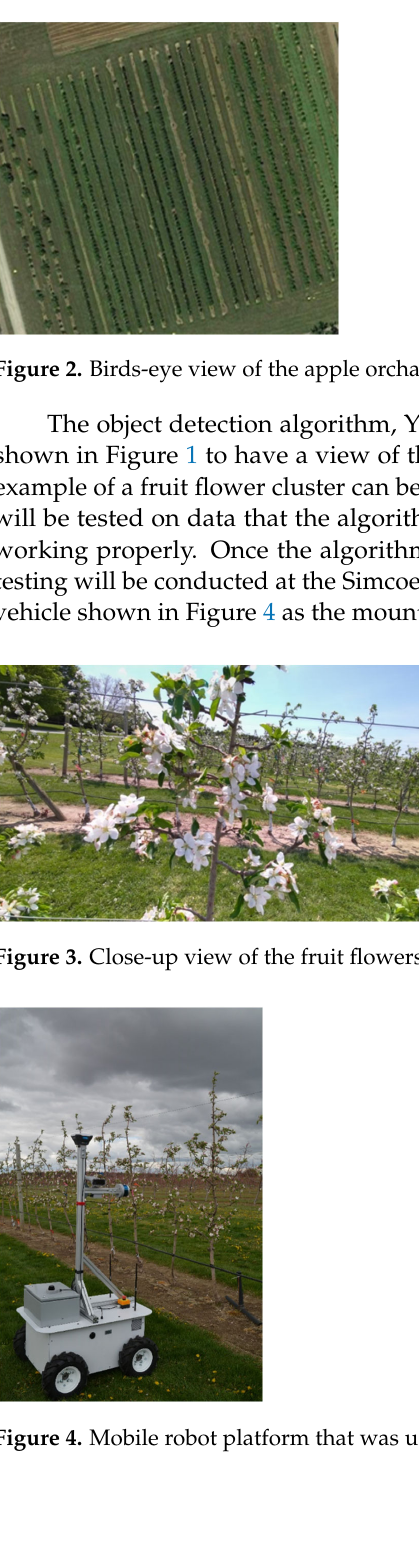
Figure 1. Spacing of the Ambrosia trees at the Simcoe Research Station in Ontario, Canada.